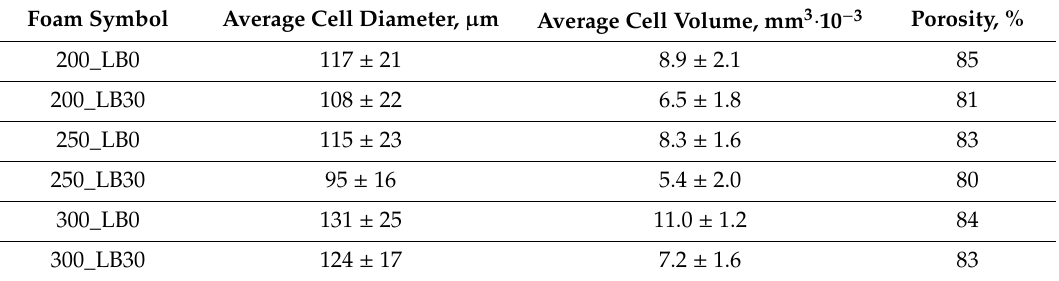
Table 4. Morphological properties of PUR-PIR